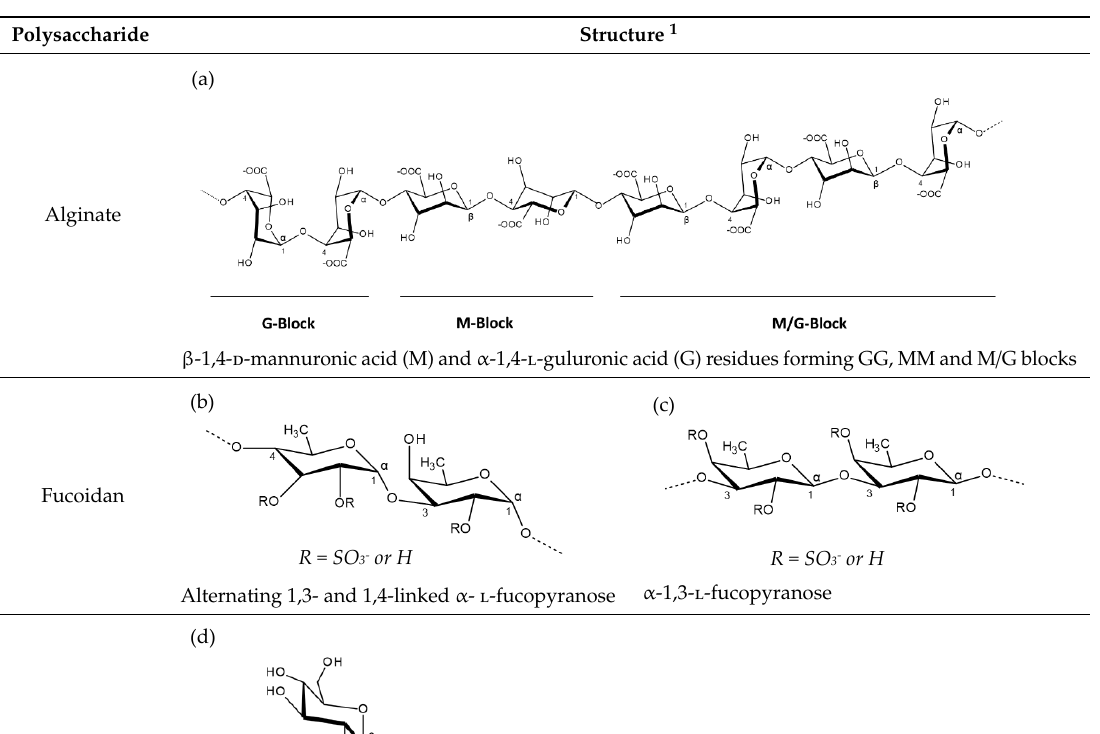
Table 1. Basic structures of polysaccharides derived from marine macroalgae: (a) alginate, (b)–(c) fucoidan, (d) laminarin, (e)–(f) carrageenan, (g)–(h) agar, and (i)–(k) ulvan (where (i)–(j): ulvanobiuronic acids and k: ulvanobiose).